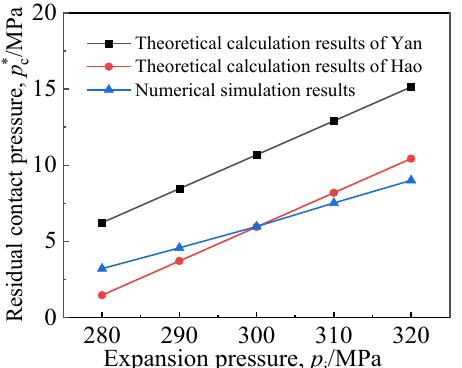
Figure 4. Comparison of calculation results [13,25] .